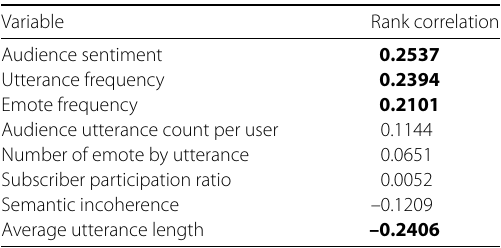
Table 3 Rank correlation of each feature against the view count group measured by Spearman’s ρ . Meaningful effect sizes are marked as bold. All correlations are statistically significant ( p <